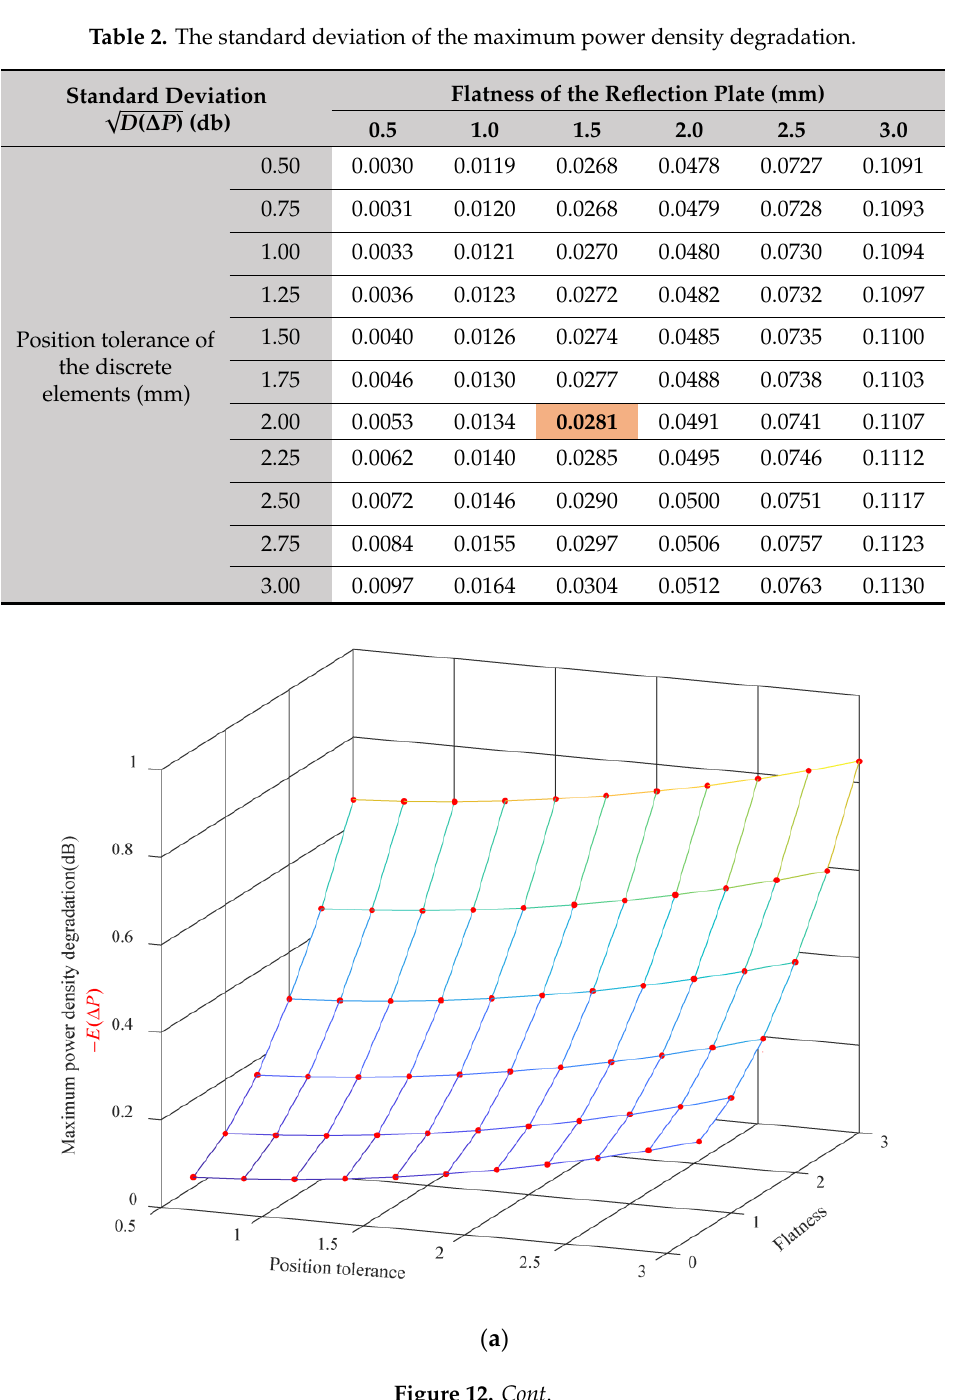
( b ) Figure 12. ( a ). The expectation of the maximum power density degradation for different hybrid tolerances T and F . ( b ). The constraint of the tolerance cost. For the optimized tolerances, the distribution parameters of the realistic gain were estimated by numerical simulation. In total, 1000 sets of samples of hybrid errors and corresponding gain were